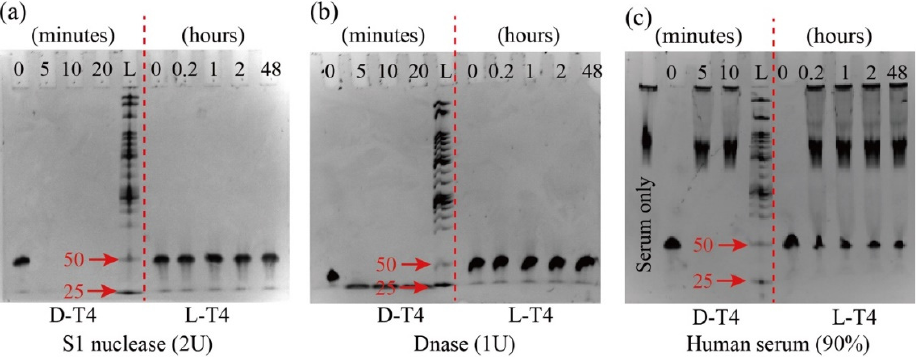
Figure 3. Stability of 48-mer D-T4 (left of the L mark) and 48-mer L-T4 (right of the L mark) under S1 nuclease of 2U ( a ), DNase of 1U ( b ), and human serum of 90% ( c ). Various timelines are also displayed. L denotes the size standard of DNA ladder (25 denotes 25bp and 50 denotes 50bp, re- spectively).